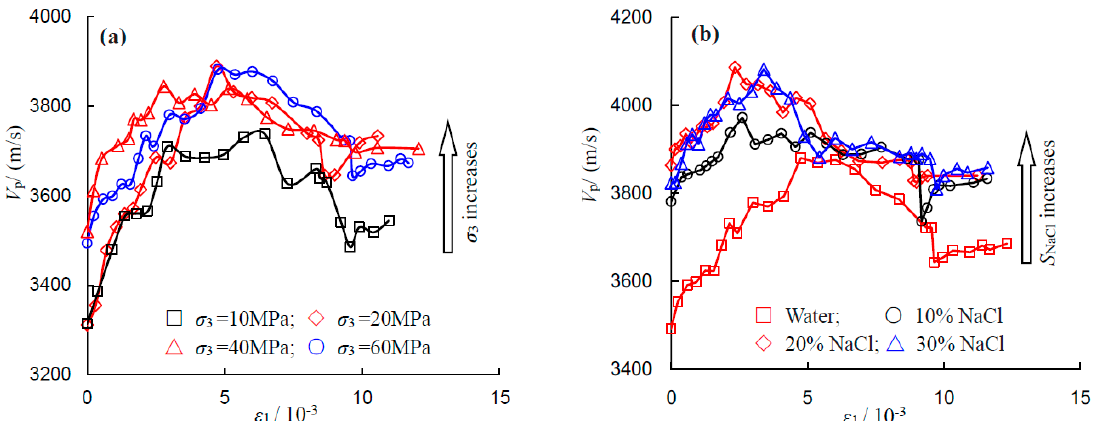
Figure 11. P-wave velocity against volumetric strain during complete failure process with respect to various salinity levels. ( a ) Water, σ 3 = 10 MPa; ( b ) 10% NaCl, σ 3 = 10 MPa; ( c ) 20% NaCl, σ 3 = 10 MPa; and ( d ) 30% NaCl, σ 3 = 10 MPa.